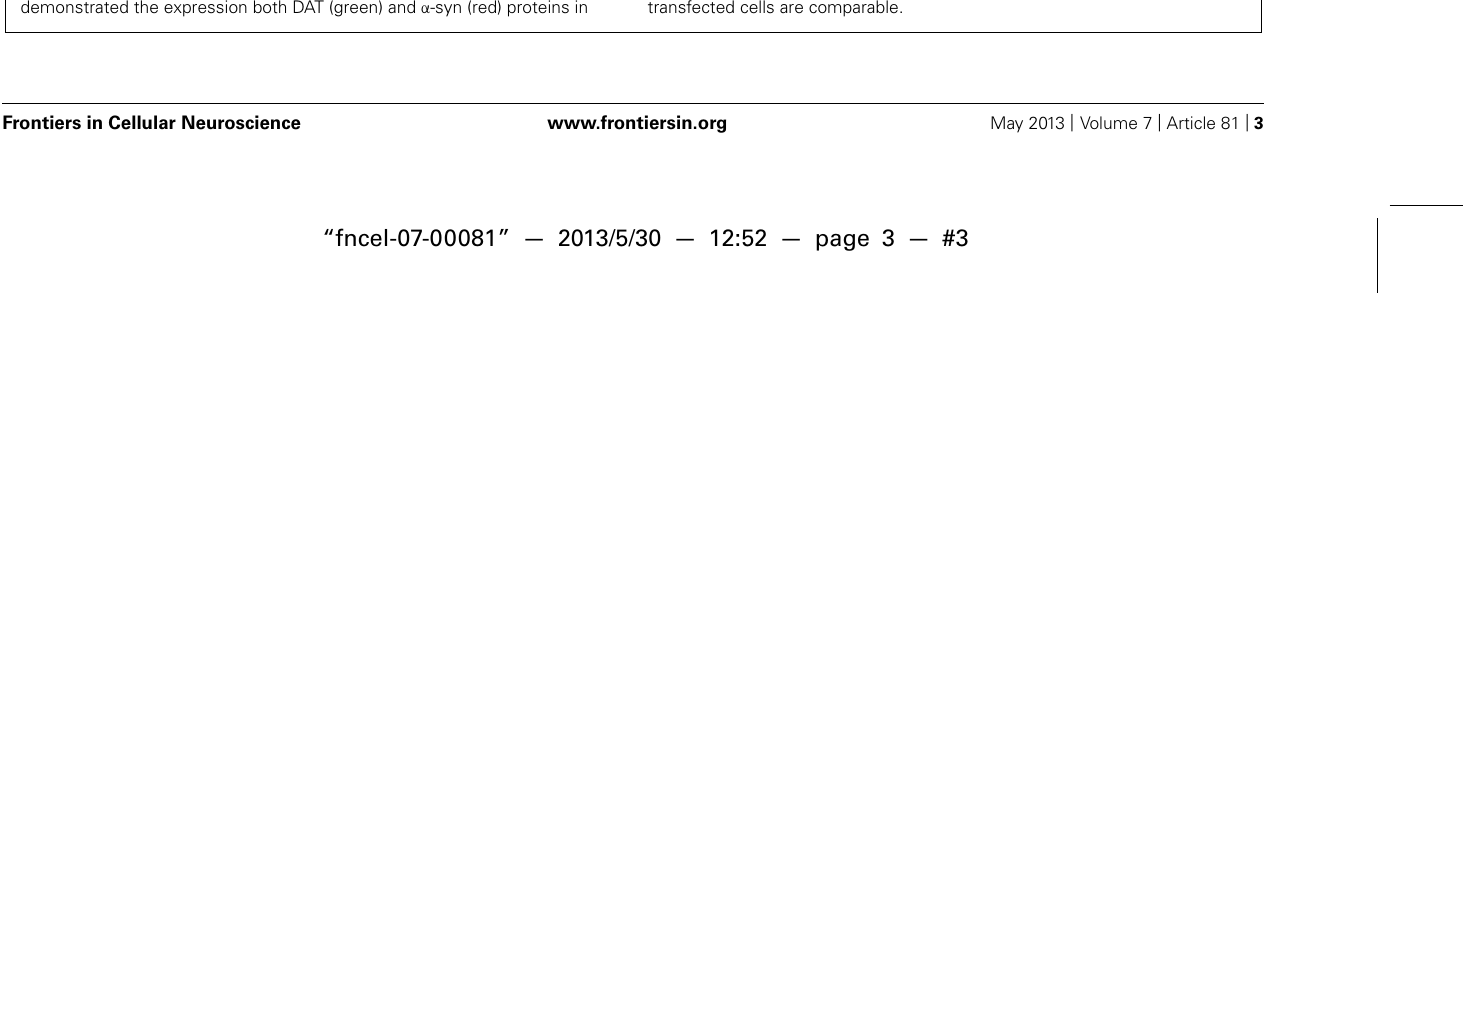
FIGURE 1 | Expression of dopamine transporter and α -syn in 3D5/DAT cell line. 3D5 cells with DAT or mock transfection were maintained in 24-well plates containing coverglasses and 6-well plates and used for (A) immunocytochemistry and (B) western blotting, respectively, after 8 days of RA differentiation and α -syn induction. Dual immunofluorescence labeling demonstrated the expression both DAT (green) and α -syn (red) proteins in